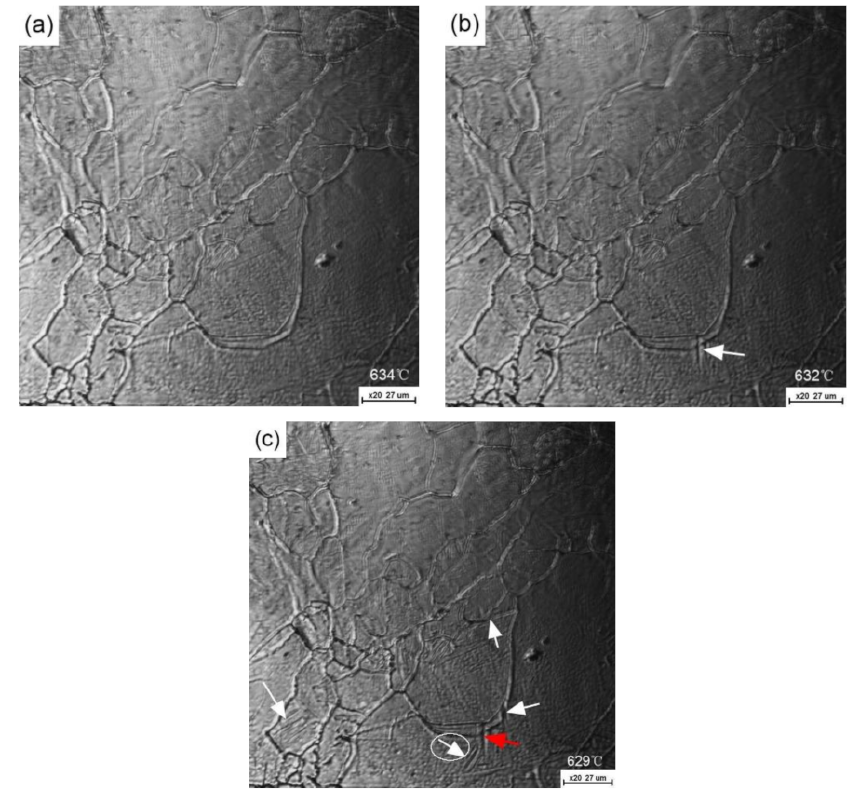
Figure 4. In situ observation of phase transformation with the CGHAZ thermal cycle: ( a ) 634 ◦ C, ( b ) 632 ◦ C, and ( c ) 629 ◦ C. (The white arrows show that the ferritic laths form at the moment of real-time photographing for each image, the red arrows show the pre-existing ferritic